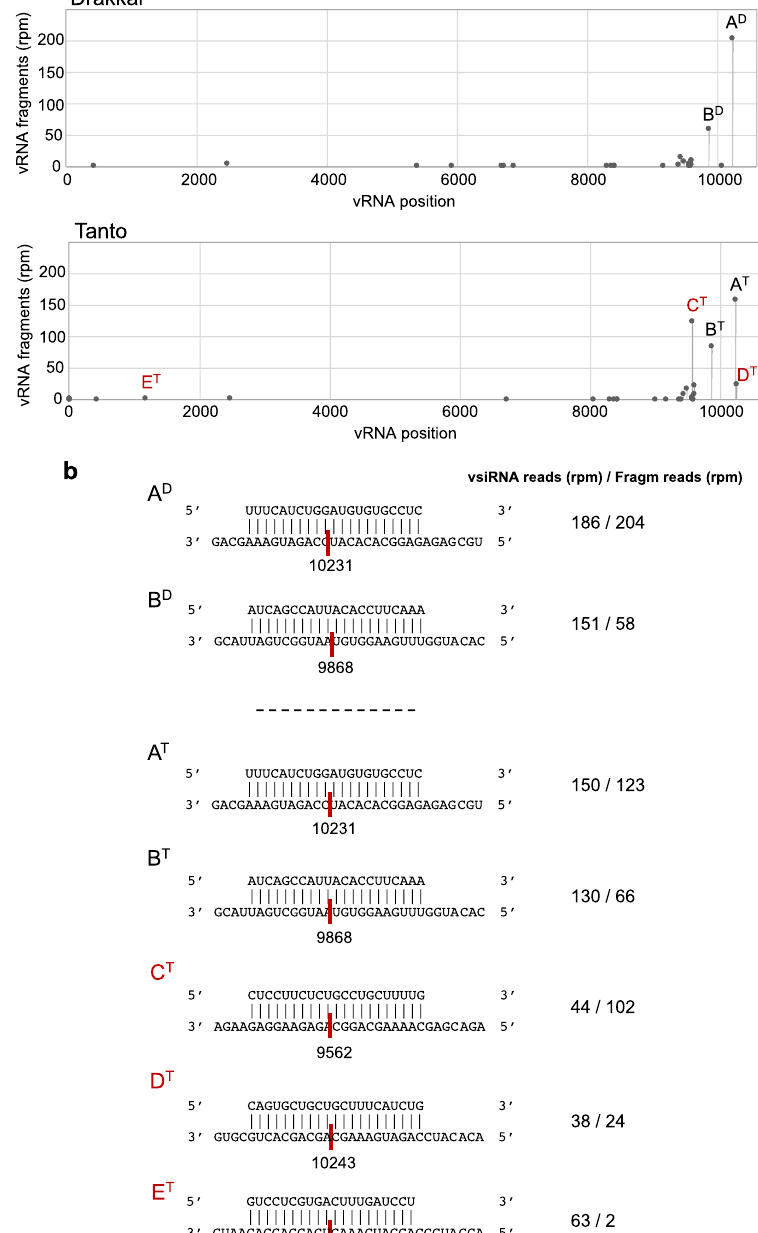
the viral genome. They were clearly discerned from a back- ground of low abundant signatures that likely represent sub- optimal cleavage sites. Three additional sites of preferential cleavage at positions 9562, 10,243, and 1182 (referred to as C, D, and E) were predominantly found in Tanto (C) or exclu- sively identi fi ed in Tanto, but not in Drakkar (D and E). As vsiRNAs are produced at very high levels from all along the viral sequence (Fig. 2), these observations suggest certain selectivity for speci fi c vsiRNAs engaging in vRNA cleavage.